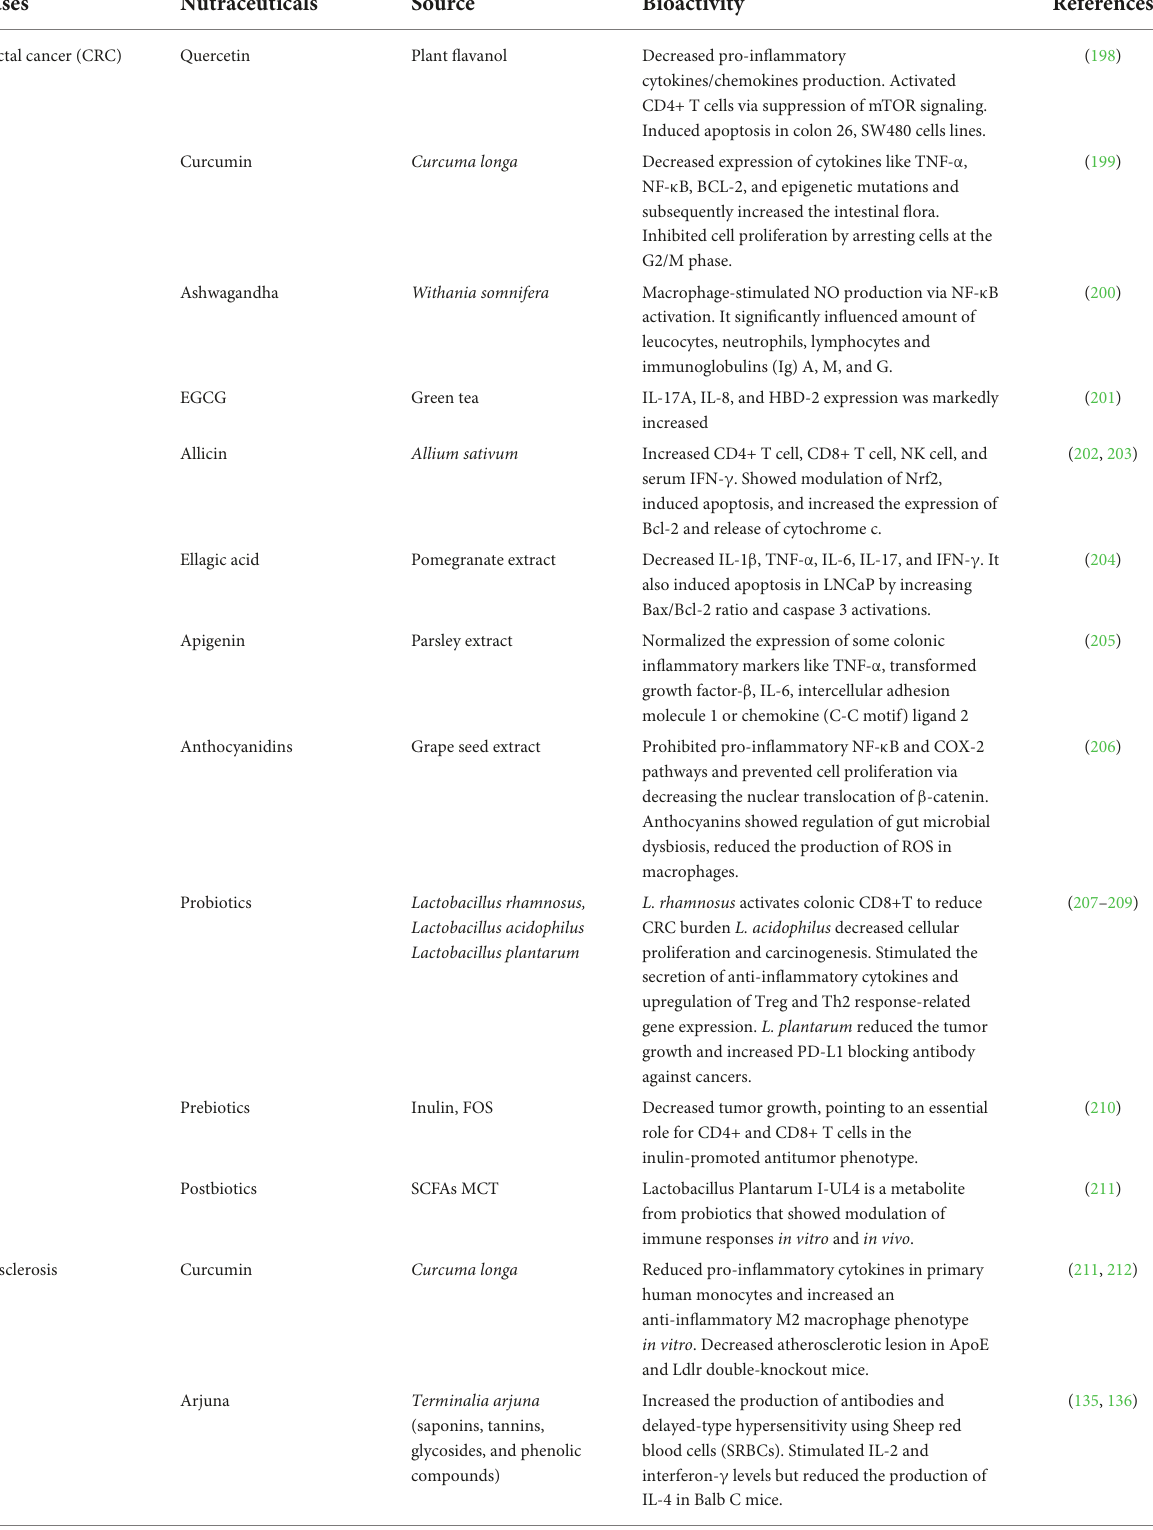
TABLE 2 Immunomodulatory roles of the nutraceuticals in CRC, and in various NCDs including atherosclerosis, diabetes, osteoporosis, polycystic ovarian syndrome, non-alcoholic fatty liver diseases, obesity, and